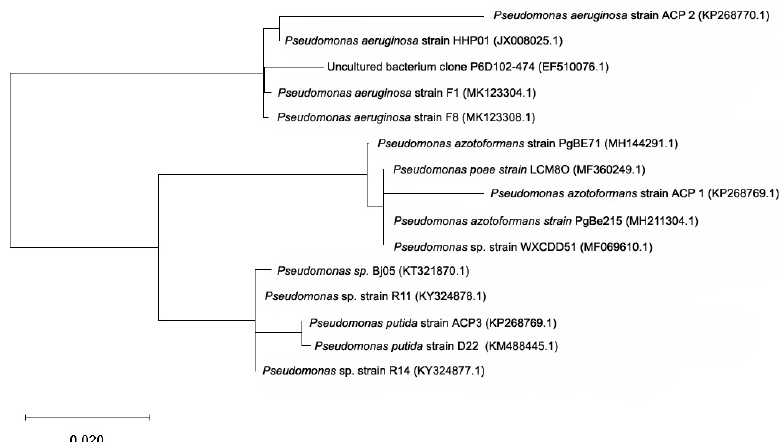
Figure 1. Phylogenetic tree of isolated Pseudomonas strains from Jalandhar, Punjab, showing relations of the strains ACP1, ACP2, and ACP3 with the closest relatives on the basis of 16S ribosomal RNA gene sequence analysis.